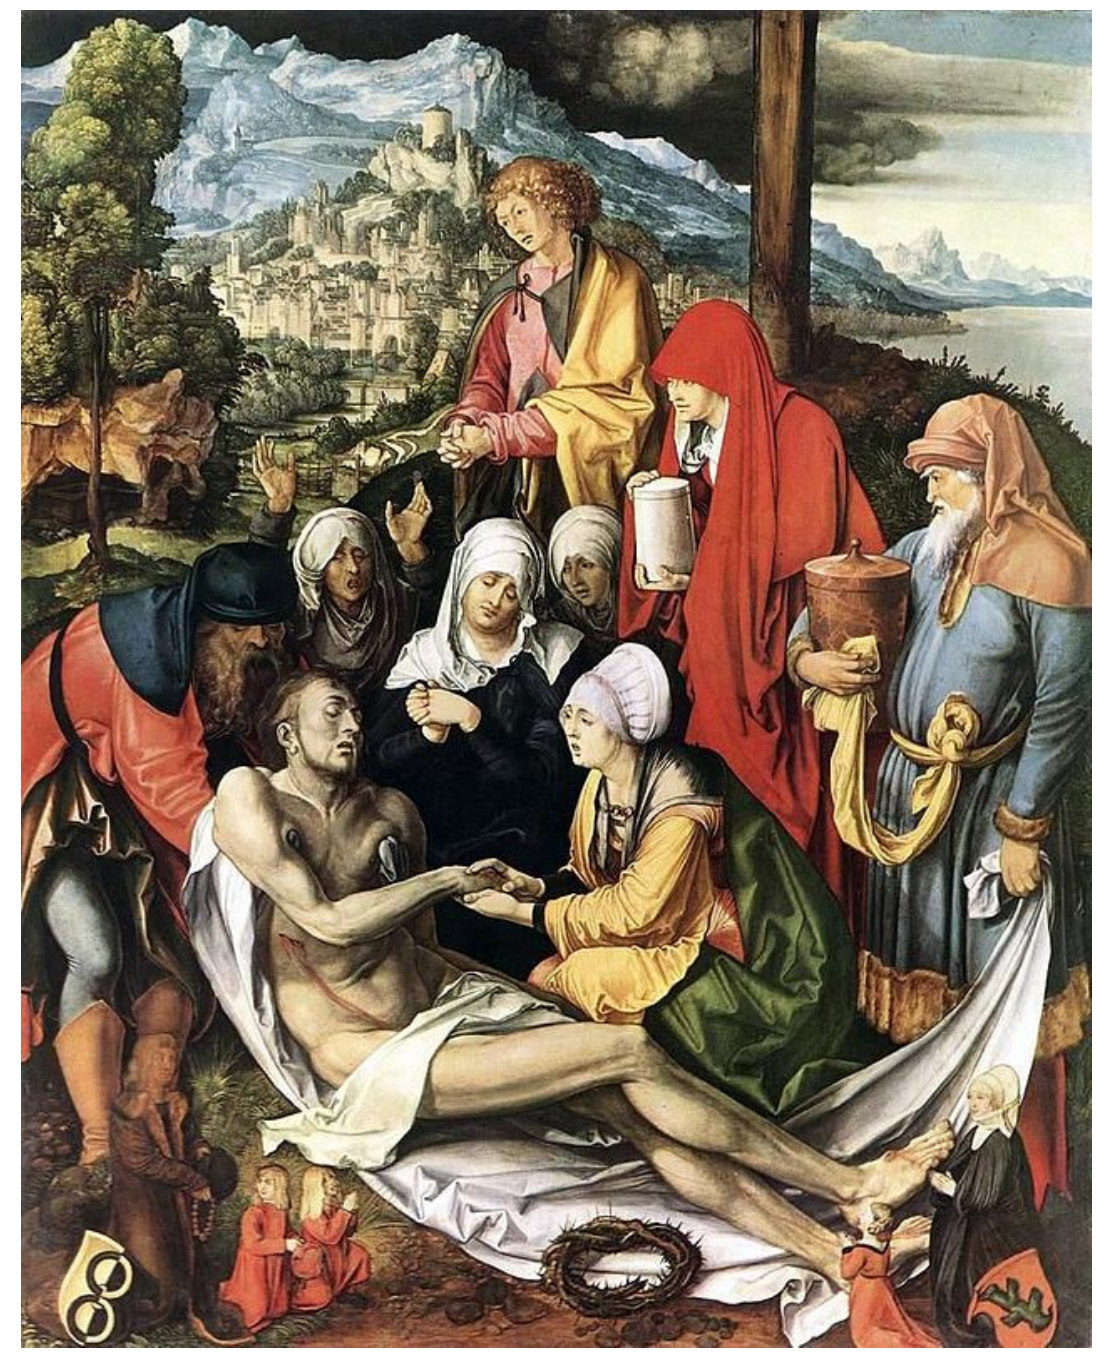
Figure 4. Albrecht Dürer, Glimm Family Lamentation , ca. 1500/03 (Munich, Alte Pinakothek). In conjunction with the hope of salvation, so essential to the perpetual prayers of the donor family in an epitaph, Kraft’s Shreyer–Landauer reliefs culminate in a Resurrection scene at the far left (Figure 5), even though chronologically this is the final Passion scene.